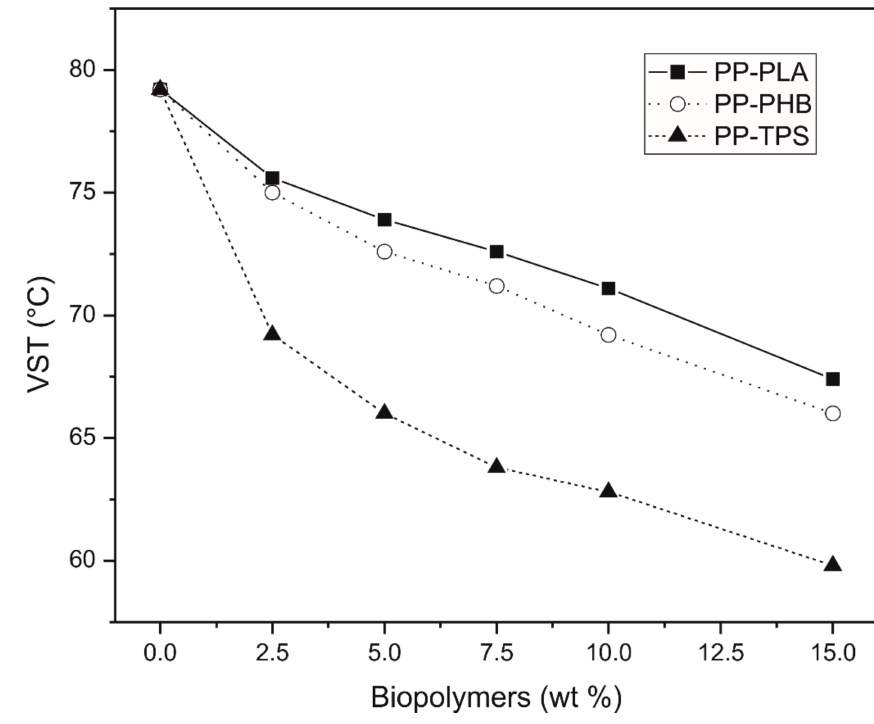
Figure 6. VST vs. wt.% biodegradable